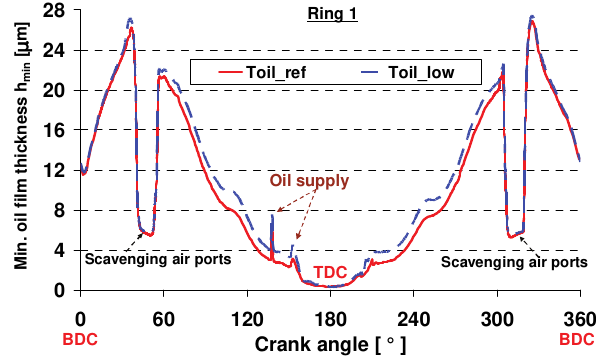
Fig. 15. Comparison of the minimum oil film thickness h min [ m m] of the 1 st (top) piston ring in case of standard oil temperature and lower oil tempera- ture distribution on cylinder